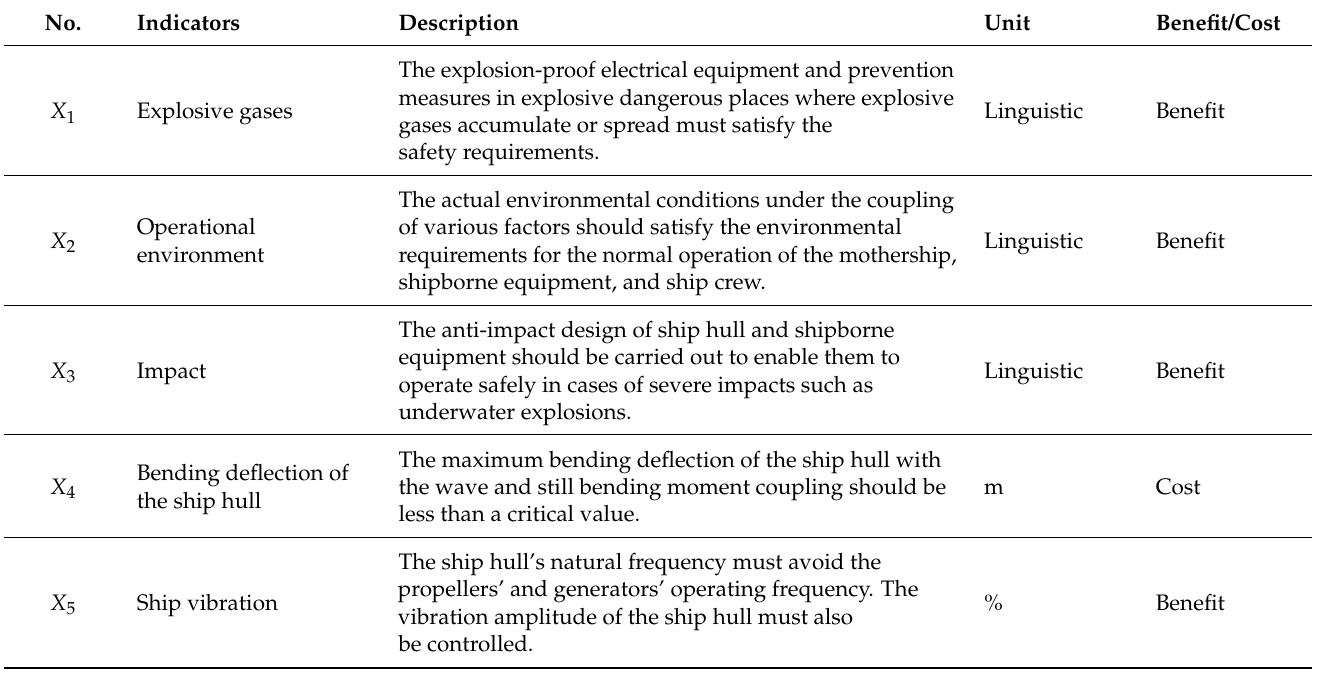
Table 6. Ship-equipment environmental suitability assessment